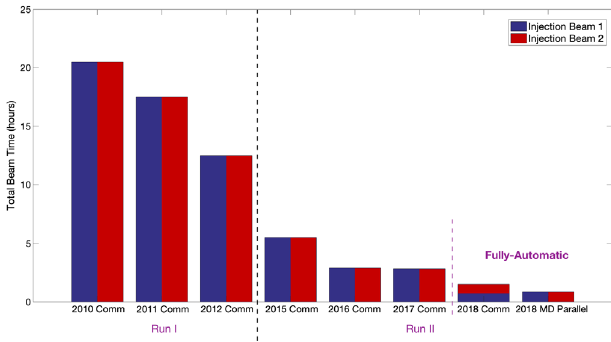
FIG. 13. The time to align 79 collimators at injection com- missioning, compared to the 2018 parallel alignment